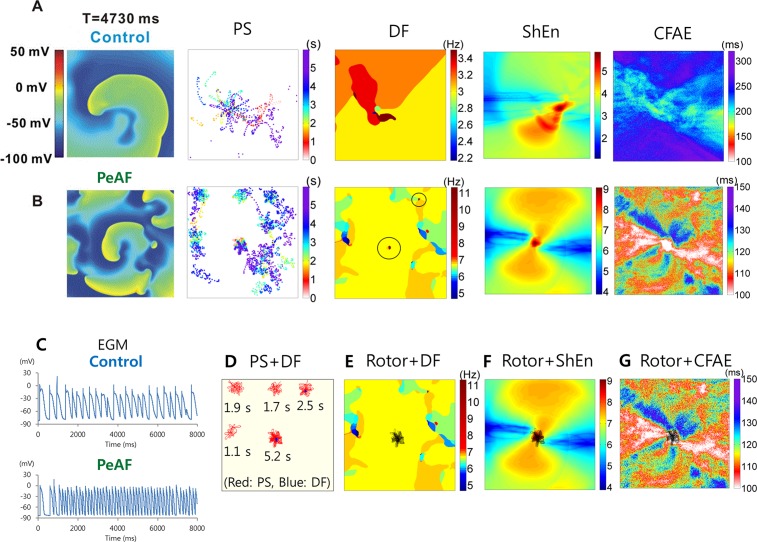
Cardiac wave dynamics around the mother rotor.Maps of voltage, PS, DF, ShEn, and CFAE under the control condition (A), at which ion current conductance values are the Courtemanche et al. [17] model values, and under AF condition (B), at which ion current conductance values are adjusted as shown in Table 1. In the DF map of the AF condition, the two highest DF areas are circled. Action potential curves are also shown for both control and AF conditions (C). D. DF areas (blue) are completely covered by the rotor tip trajectories (red). E. The trajectory of the mother rotor tip (black) is overlaid on the DF map. F. The trajectory of the mother rotor tip (black) is overlaid on the ShEn map. G. The trajectory of the mother rotor (black) tip is overlaid on the CFAE map.